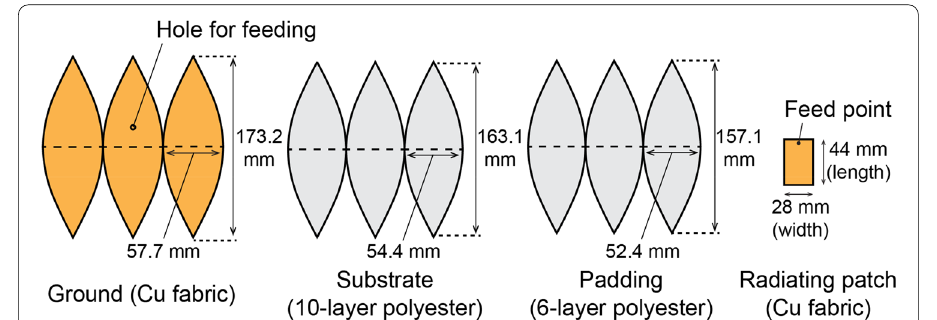
Fig. 5 Flat patterns of the antenna components